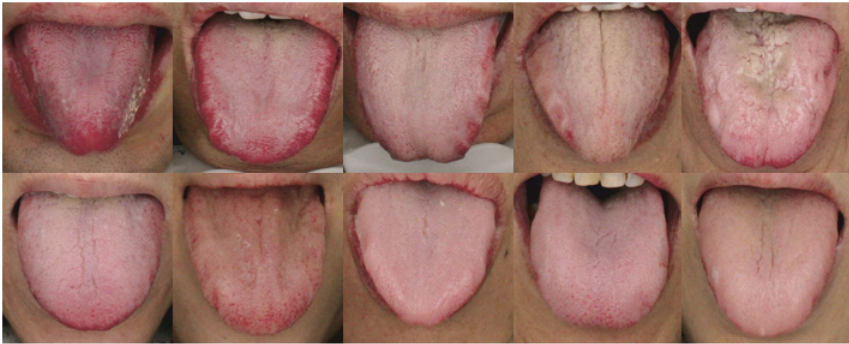
Figure 12. The OCC corrected images in the closed